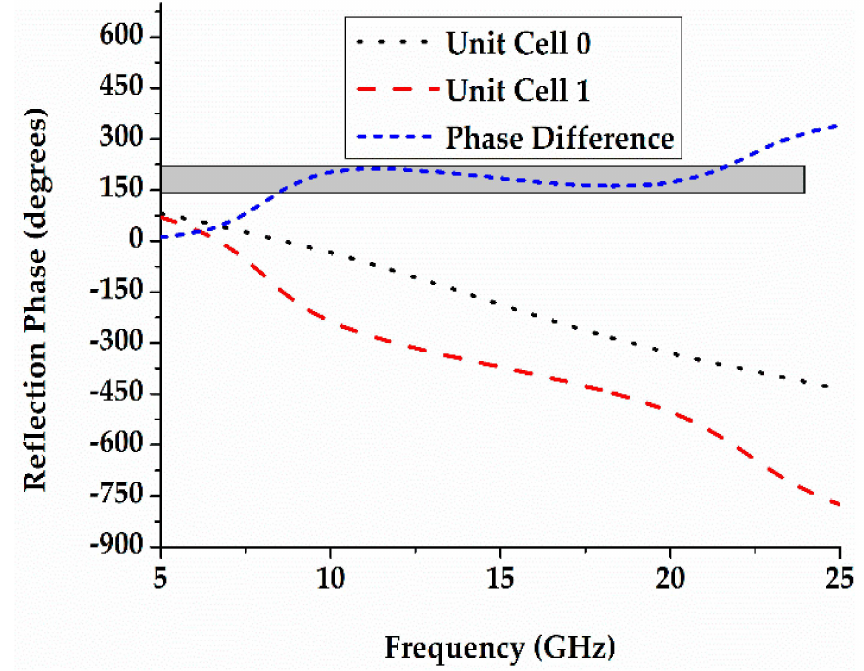
Figure 3. The reflection phase di ff erence of unit cell “1” and